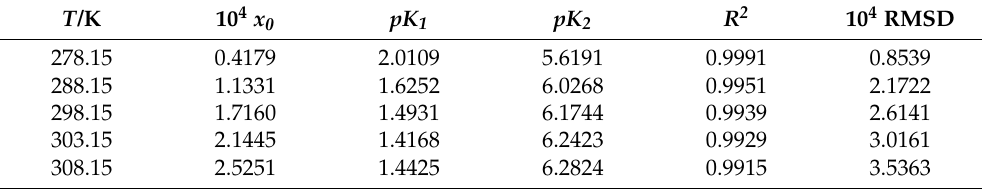
Table 4. Tsuji equation fitting parameters for the solubility of 7-ADCA in water affected by pH.